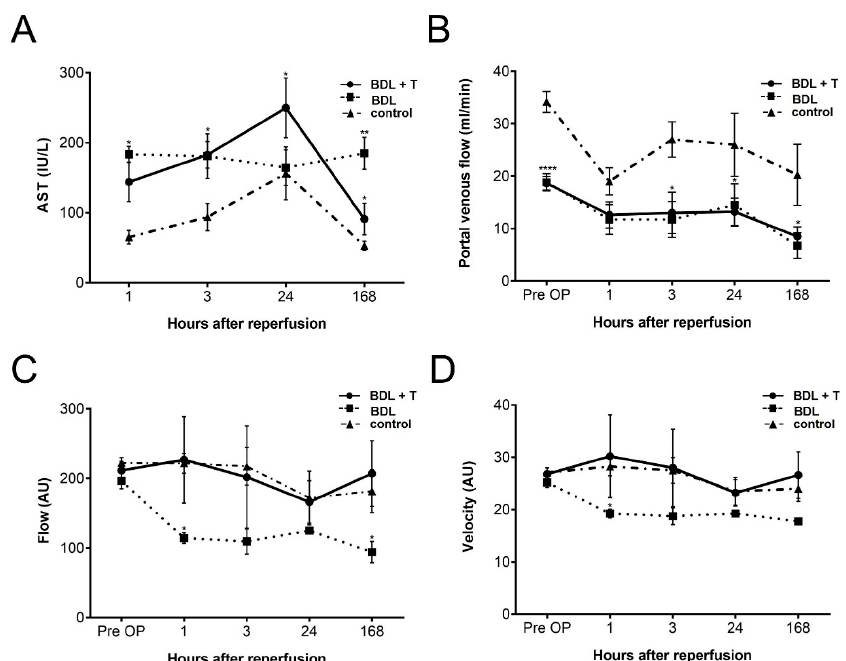
Figure 2. Hepatocellular damage, circulation, and microcirculation in the different treatment groups were analyzed based on ( A ) serum aspartate aminotransferase (AST) levels, ( B ) portal venous flow, ( C ) flow, and ( D ) velocity pre-operative, 1, 3, 24, and 168 h after reperfusion. Mean and standard deviation are shown in each group with significance levels of * p < 0.05, ** p < 0.01, **** p <